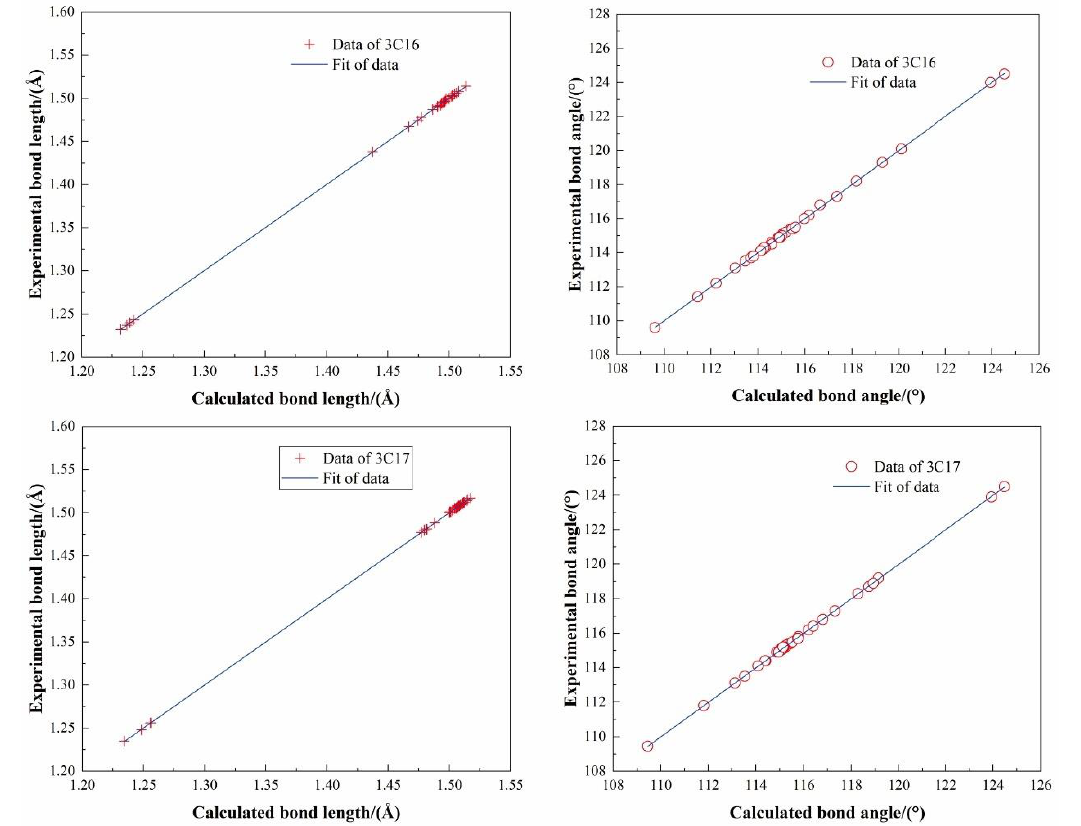
Figure 10. The correlation diagrams between the experimental bond length/angle of the title com- pounds by X-ray single crystal diffraction and the calculated bond length/angle by DFT.